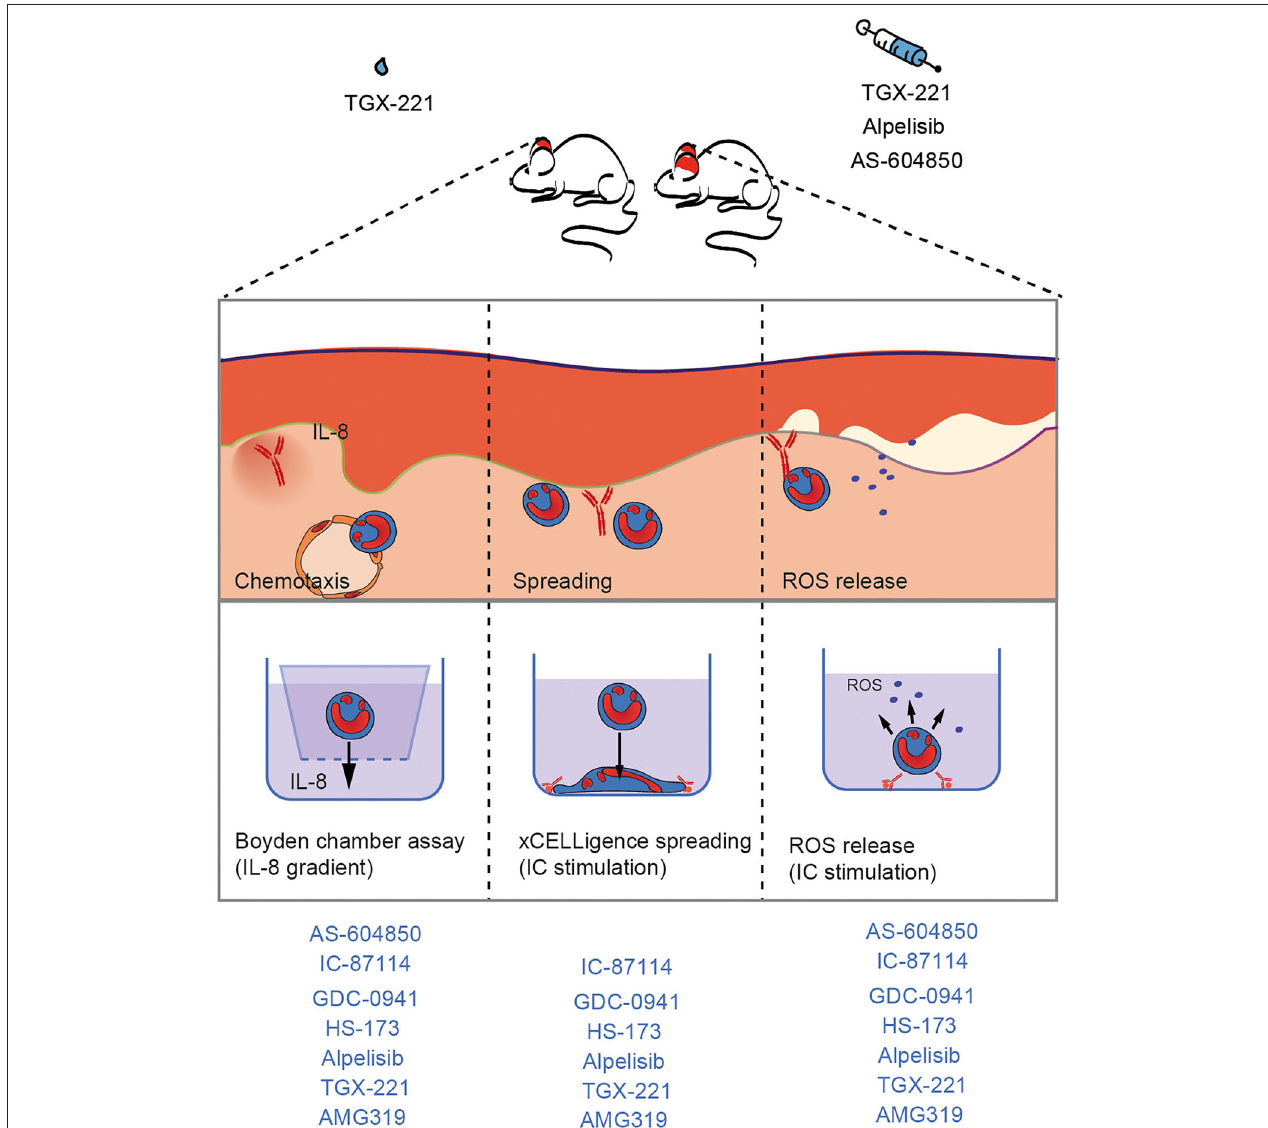
FIGURE 6 | Unique impact of different PI3K inhibitors on neutrophil-dependent processes in EBA. In the pathogenesis of IC-induced EBA, PMN exert their pathogenic effects in a stepwise manner that is initiated by attracting them into the tissue (chemotaxis), spreading, and adhesion to surfaces of IC deposits and ultimately results in the release of pro-inflammatory substances, such as ROS. As these processes strongly depend to PI3K, inhibition leads to improvement of